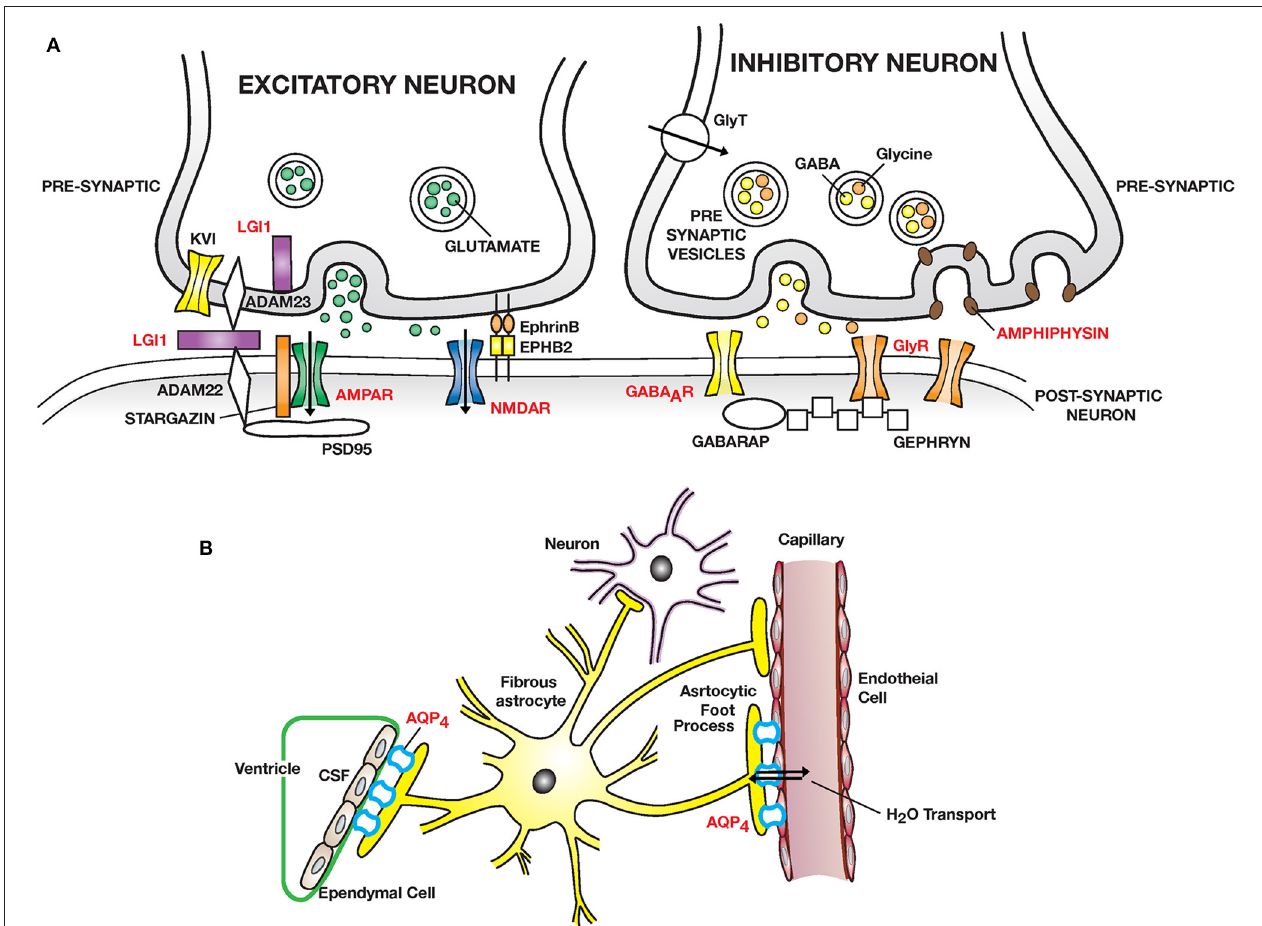
FIGURE 1 | Autoimmmune diseases of the CNS: (A) Excitatory synapses: NMDAR encephalitis is caused by anti–NMDA receptor (NMDAR) antibodies binding and cross-linking GluN1 subunits, disrupting interaction of NMDAR with ephrin type B receptor 2 (EPHB2) causing internalization of NMDAR and impaired glutamergic transmission. LGI1 encephalitis is caused by auto-antibodies to leucine rich glioma inactivated protein 1 (LGI1), a neuronal glycoprotein secreted into the synapse. LGI1 interacts with presynaptic disintegrin and metalloproteinase domain-containing protein 2 (ADAM23) and postsynaptic ADAM22, modulates AMPA receptor trafficking and presynaptic Kv1, voltage gated potassium channel function. PSD95, post-synaptic density protein 95. Other receptors targeted: AMPAR; mGluR1/5. Inhibitory synapses: Autoantibodies to GABA type A receptor (GABA A R) on inhibitory synapses may lead to encephalitis with intractable seizures. Autoantibodies to the glycine receptor (GlyR) cause painful spasms; progressive encephalitis with rigidity and myoclonus (PERM). Stiff person syndrome can also be caused by auto-antibodies to amphiphysin, a presynaptic protein expressed in all synapses, important in clathrin mediated endocytosis leading to a decreased number of presynaptic vesicles filled with neurotransmitter available for exocytosis. Higher tonic activity may make inhibitory synapses (release of GABA and glycine) especially vulnerable. GABARAP, GABA associated receptor protein. GAD, decarboxylates glutamate to GABA (not shown). (B) Neuromyelitis optica (NMO) is caused by auto-antibodies to Aquaporin 4 (AQP4) water channel expressed widely in the body including on astrocytic foot processes abutting capillary endothelial cells and ependymal cells. Predominant pathology is in spinal cord, optic nerve and brain peri-ependymal